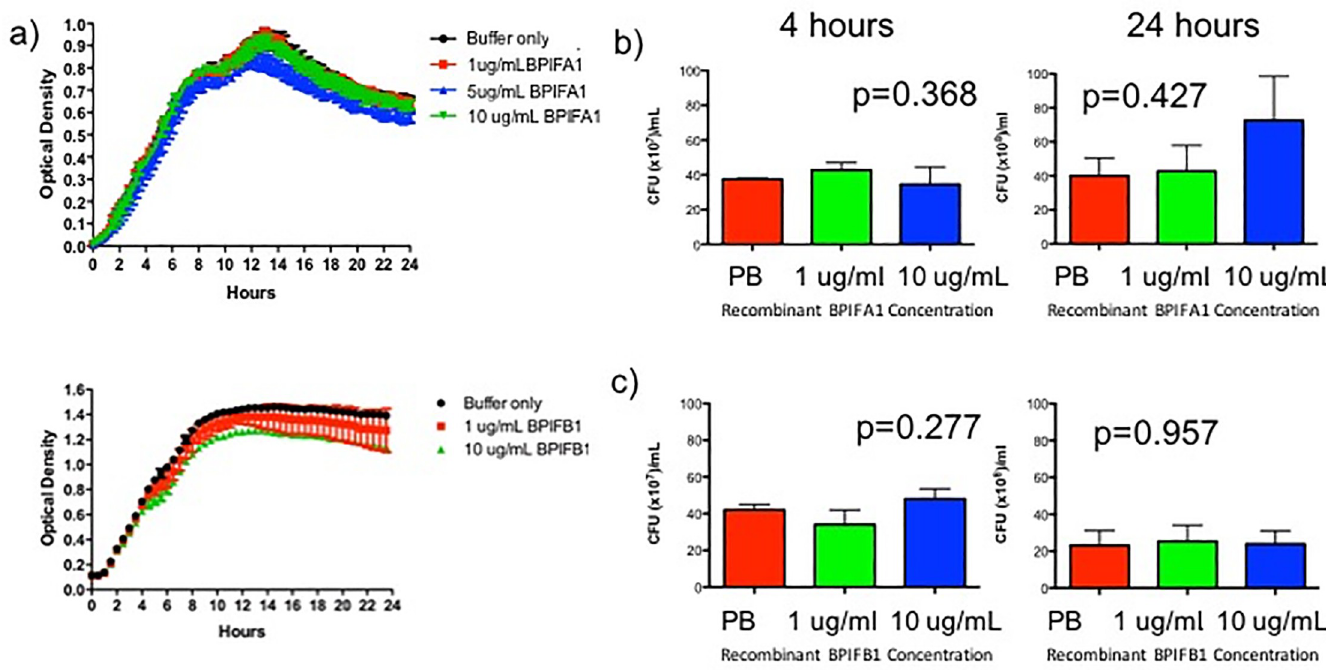
Fig 3. P . aeruginosa growth curves and colony forming units with the addition of BPIFA1 or BPIFB1 recombinant proteins. a) Growth curves of the PAO1 strain of P . aeruginosa treated with 1, 5 and 10 μ g of recombinant BPIFA1 or 1 and 10 μ g of BPIFB1 protein. b-c) Quantification of colony forming units in P . aeruginosa pretreated with recombinant BPIFA1 (b) or recombinant BPIFB1 (c). Values represent mean plus standard error of the mean. The Kruskal-Wallis test was used to assess for statistical differences in colony forming units between conditions and the corresponding P values are shown. Colony forming units were measured at 4 hours and 24 hours of bacterial culture